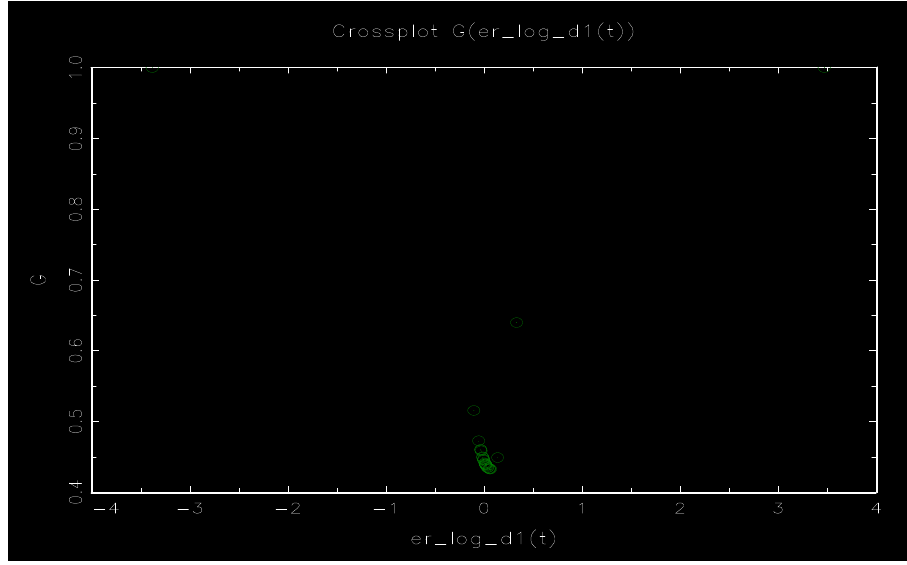
Int. J. Environ. Res. Public Health 2020 , 17 , x Figure 4. Schematic diagram of the conversion function G. Figure 4. Schematic diagram of the conversion function G.